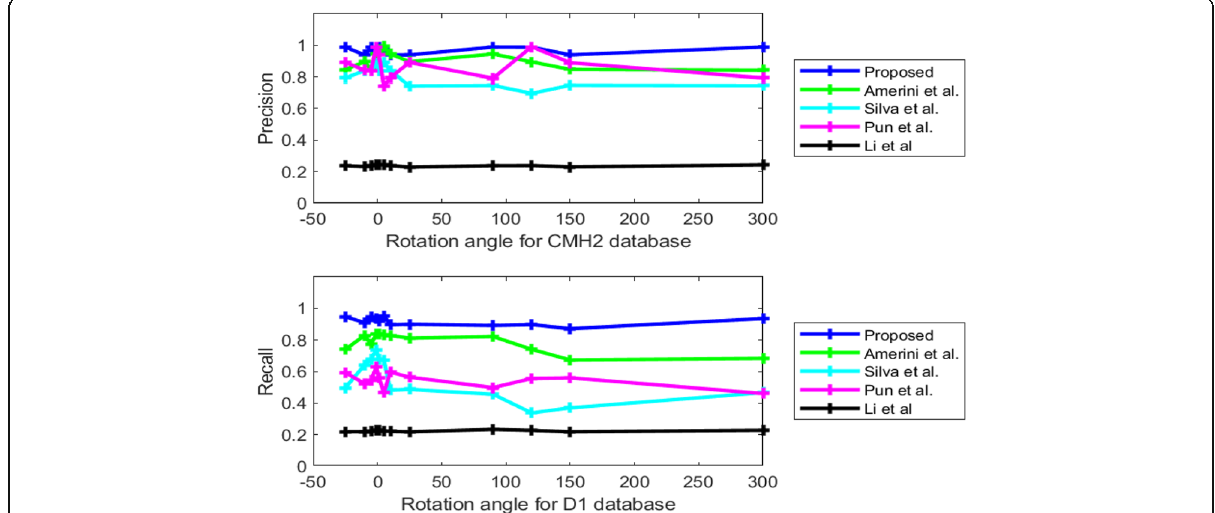
Fig. 10 The precision and recall values under the different rotation angles compared to our proposed method, Amerini et al. ’ s method, Silva et al. ’ s method, Pun et al. ’ s method, and Li et al.